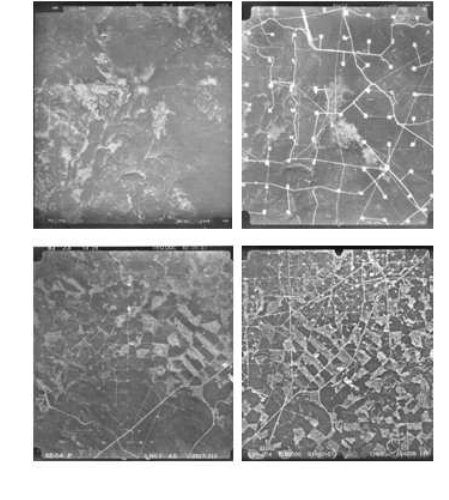
Fig. 2. Aerial photos of change in the study area: Swan Hills 1949, 1964, 1982,